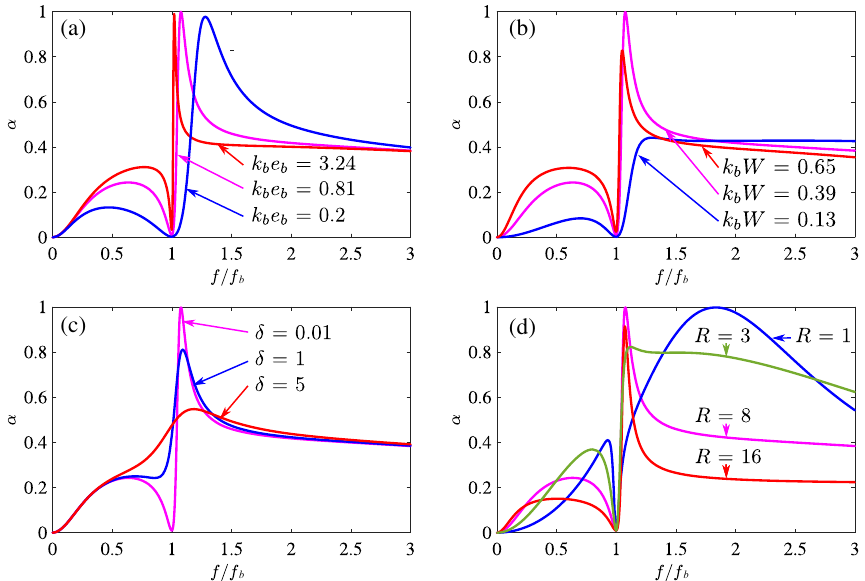
Figure 3. Absorption coef fi cient computed by the mono-articulated model as a function of the normalised frequency. (a) Variation of the mass of the beam. (b) Variation of the thickness of the cavity. (c) Variation of the structural damping. (d) Variation of the resistance. The magenta curves are the same that in Figure